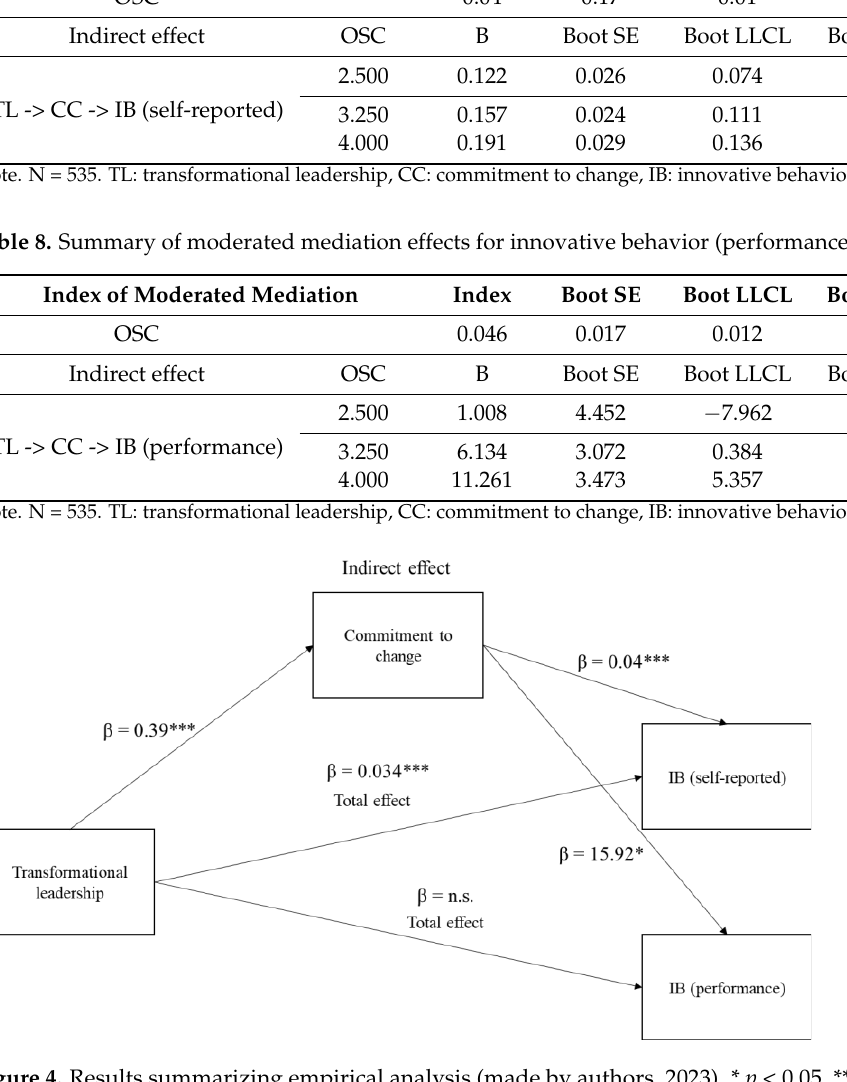
Figure 4. Results summarizing empirical analysis (made by authors, 2023) . * p < 0.05, *** p < 0.001, n.s.; not significant. n.s.; not